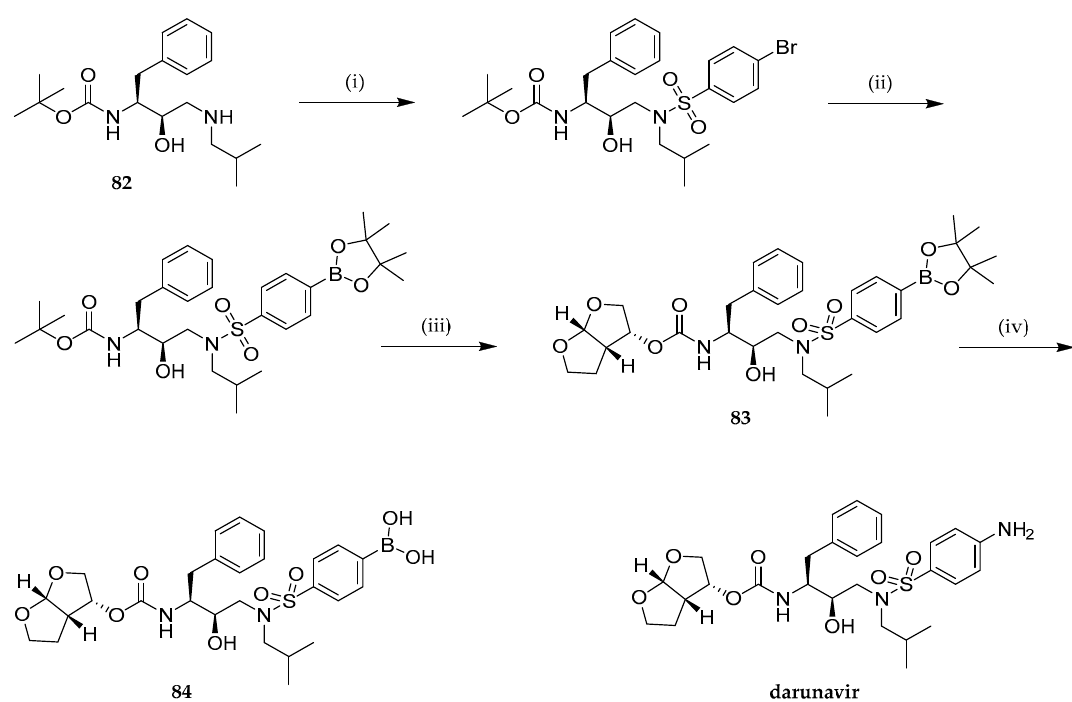
Scheme 19. Synthesis of HIV-1 protease inhibitor 84 based on the drug darunavir. Reaction conditions: ( i ) TEA, 4-bromobenzenesulfonyl chloride, CH 2 Cl 2 , dry N 2 atmosphere, 0 ◦ C, 16 h; ( ii )